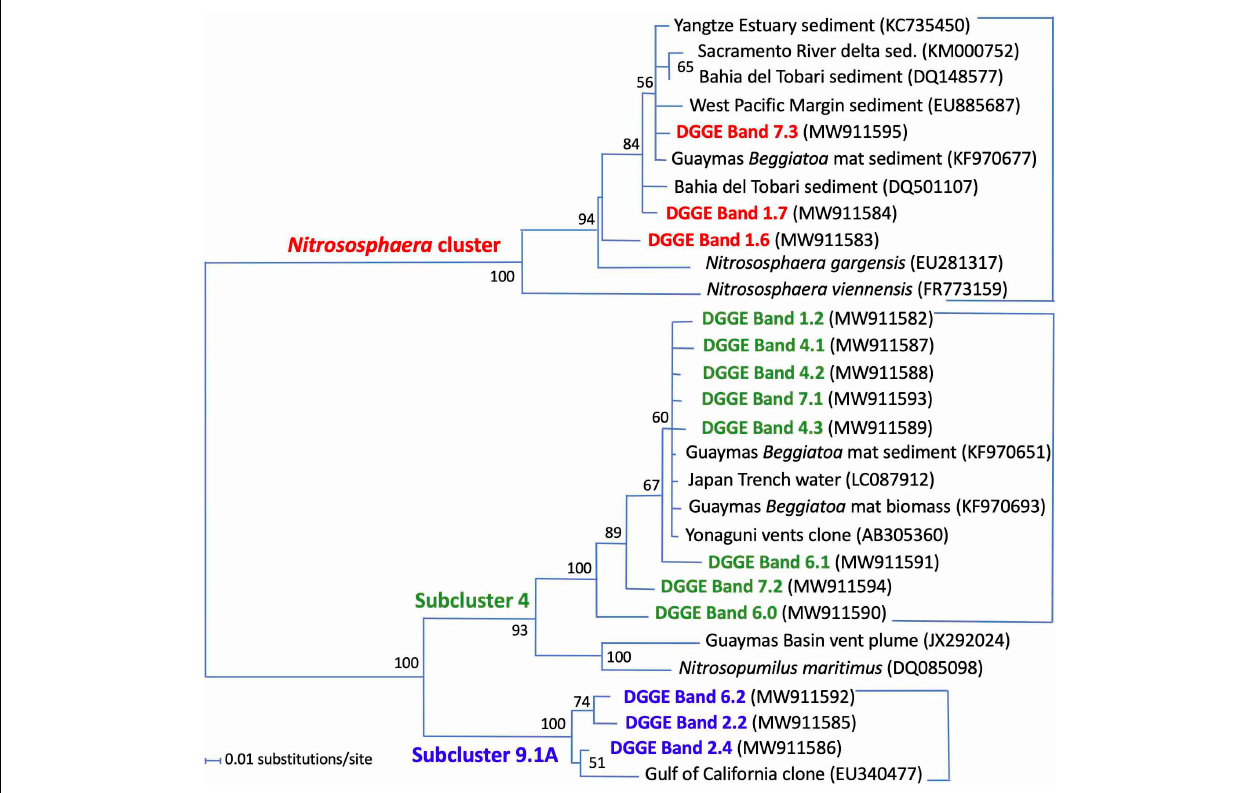
FIGURE 5 | Distance phylogeny of archaeal amoA gene DGGE fragments, based on complete amplicon length minus primer sequences, color-coded to match the DGGE bands in Figure 4 . Bootstrap support for nodes (in%) was derived from 1000 iterations.